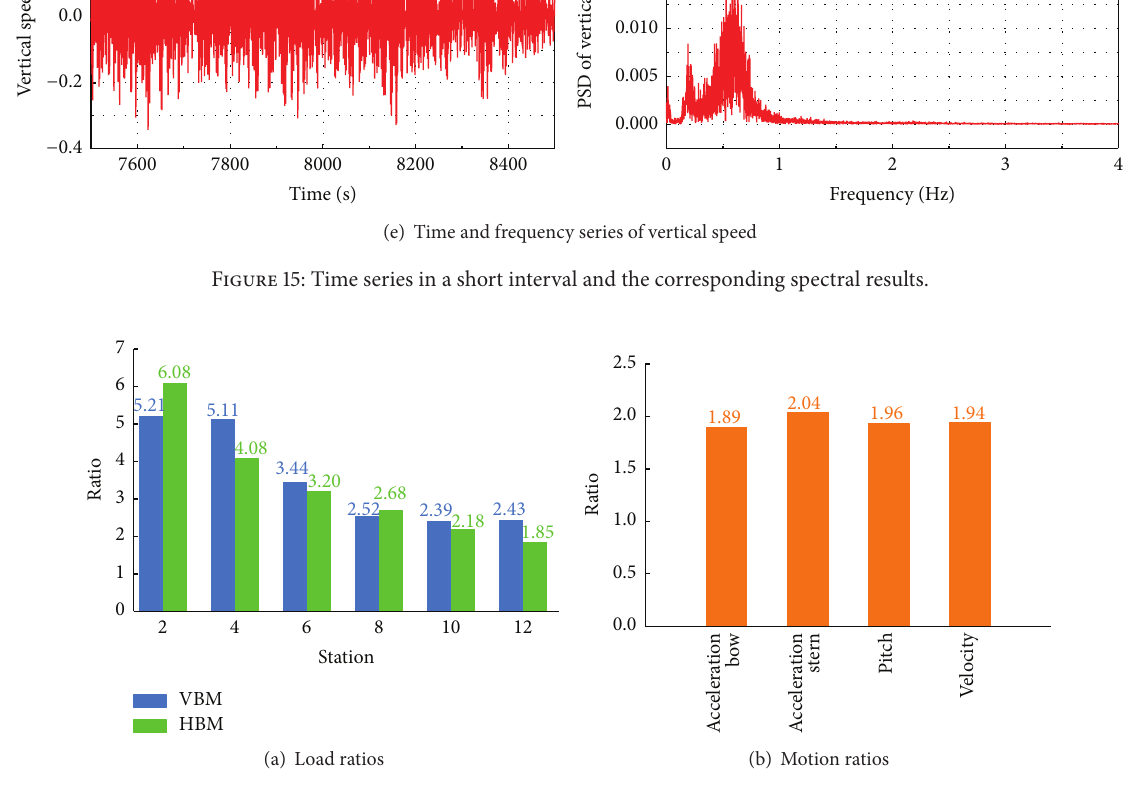
Figure 16: Ratios of extreme value to significant amplitude value.